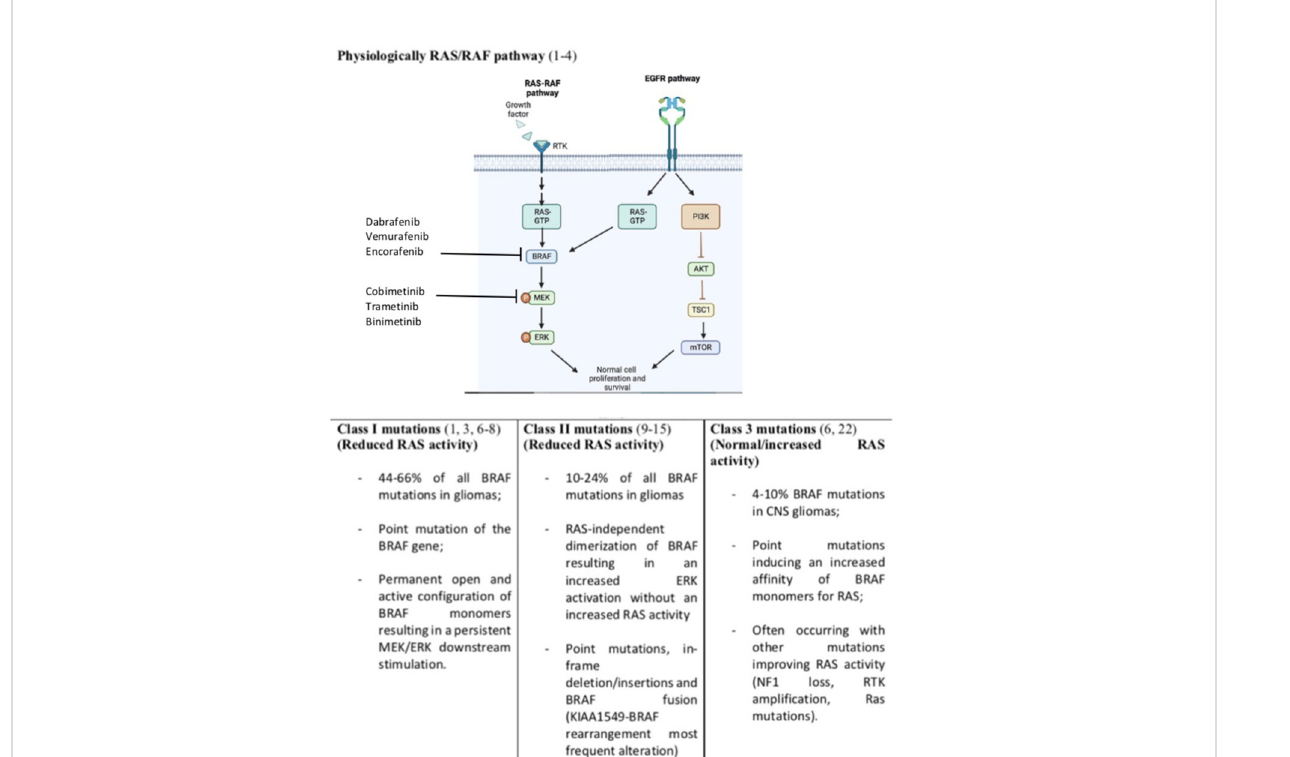
FIGURE 1 Normal RAS/RAF pathway and BRAF mutations resulting in survival and growth stimulation. Incidence of BRAF mutations are referred to glioma tumors only. We included also EGFR (Epidermal Growth Factor Receptor) pathway and its connection with RAS stimulation. Notably EGFR activation lead also to Phosphatidyl-Inositol 3-Kinase (PI3K), inhibition of the protein kinase B (Akt) and activation of the mechanistic target of rapamycin (mTOR) converging on cell survival and